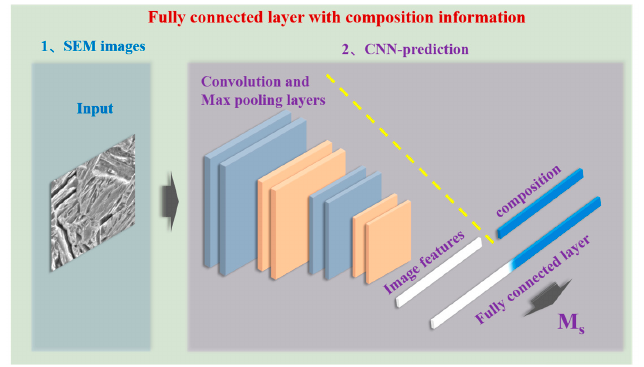
Figure 9. Framework of the CNN model after addition of microstructure information from the fully connected layer. connected